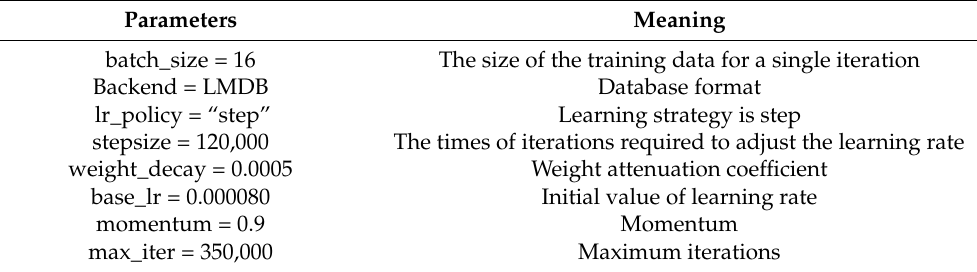
Table 3. The setting of the main